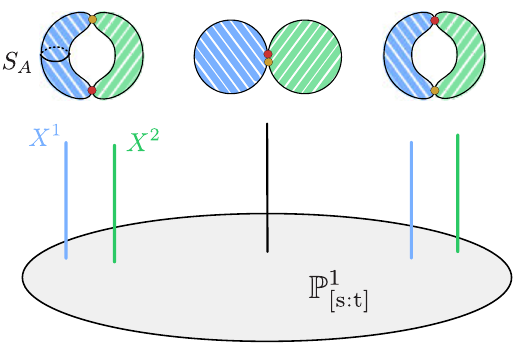
Figure 4 . Kulikov Type II.b degeneration. Note that the nodes exchange under mondromy around the singular configuration shown in the